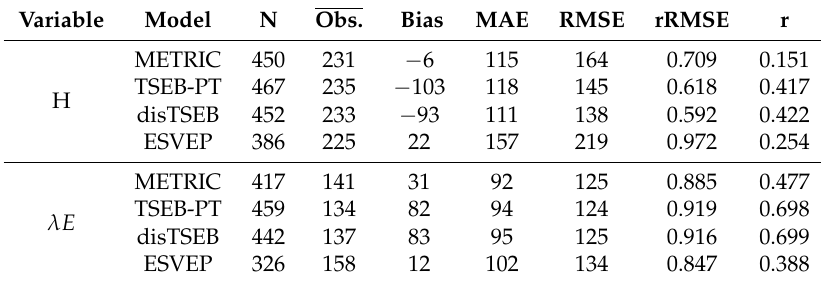
Table 4. Error metrics for METRIC, TSEB-PT, disTSEB (TSEB-PT with flux disaggregation) and ESVEP modelled fluxes using Decision Tree sharpened temperatures and closing the energy balance gap in field measurements by preserving the Bowen ratio. N, number of valid cases; Obs.; mean of observed values (W m − 2 ); bias, mean difference between predicted and observed (W m − 2 ); MAE, Mean Absolute correlation coefficient